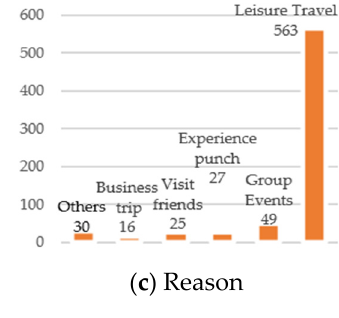
Figure 8. Chart of other population data indicators.